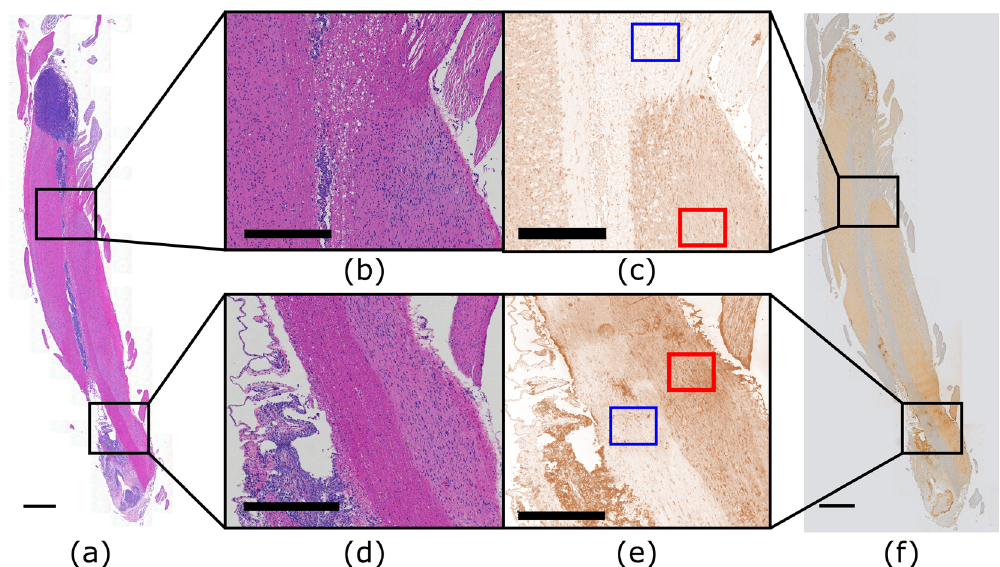
Figure 7. Spinal cord tissue of an LM rat prepared for histology showing tumor burden and trastuzumab distribution. ( a , b , d ) Stained with hematoxylin and eosin to view gross tumor morphology. ( c , e ) Stained with an anti-human IgG antibody to detect trastuzumab distributed throughout the tissue then deconvolved in ImageJ to visualize DAB signal. ( b , c ) Enlarged views of untargeted healthy tissue. White matter ROI contoured in blue and grey matter ROI contoured in red in slide c. ( d , e ) Enlarged views of targeted healthy tissue. White matter ROI contoured in blue and grey matter ROI contoured in red in slide e. ( f ) Stained with an anti-human IgG antibody to detect trastuzumab distributed throughout the tissue. Scale bars: ( a , f ) 1 mm; ( b – e ) 0.5